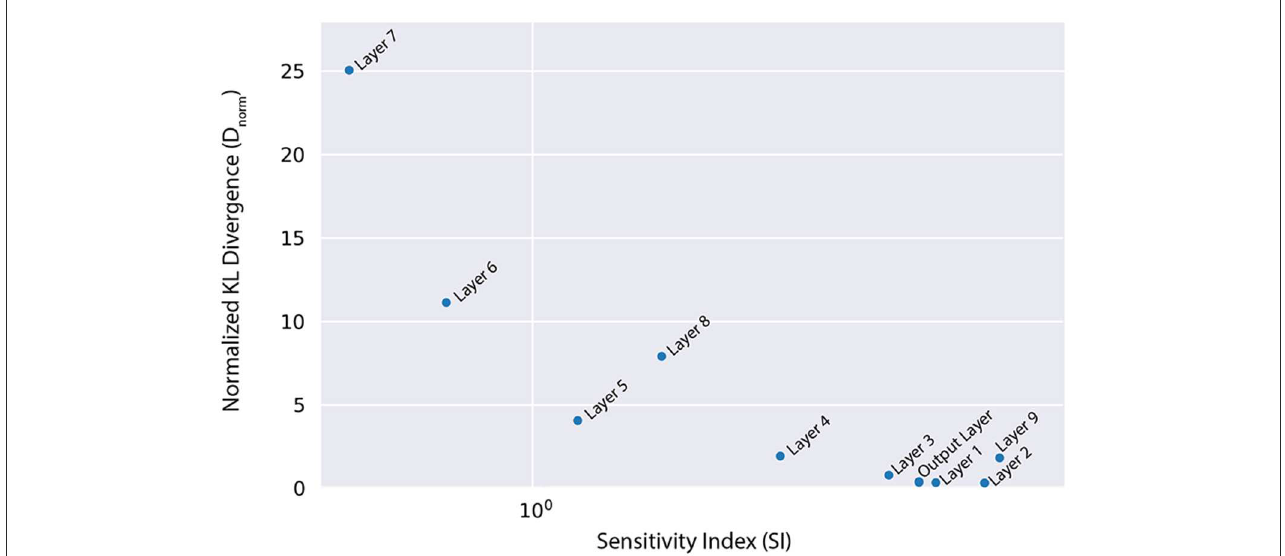
FIGURE4 Normalized KL divergence from the full BNN posterior push-forward to the different pBNNs is highly correlated with the SI that is used to select the layer for Bayesianization (Spearman’s correlation r s = −